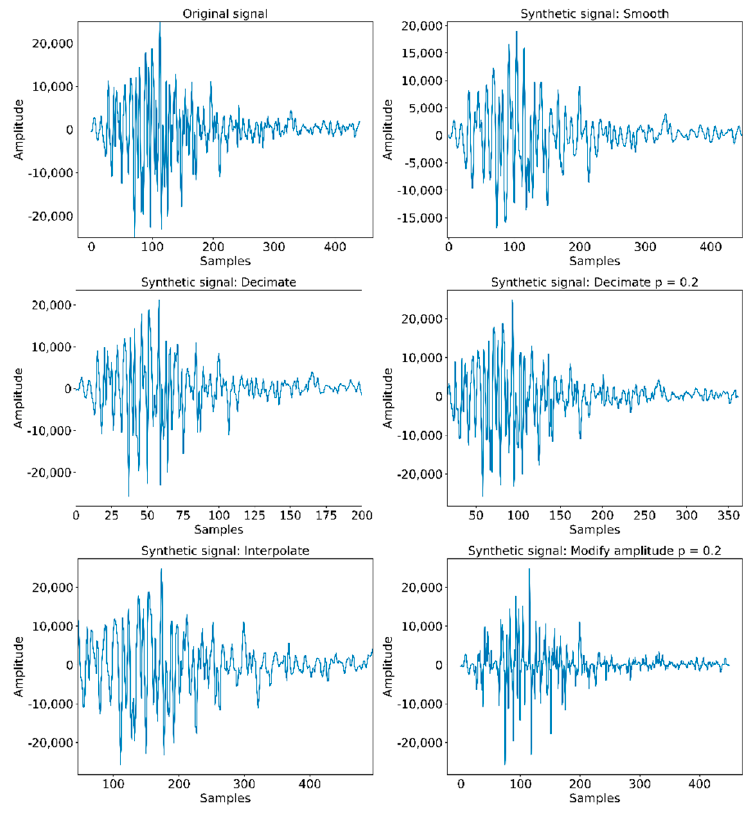
Figure 12. Example of synthetic signal generation. Table 2. Sample sets obtained for the convolutional network